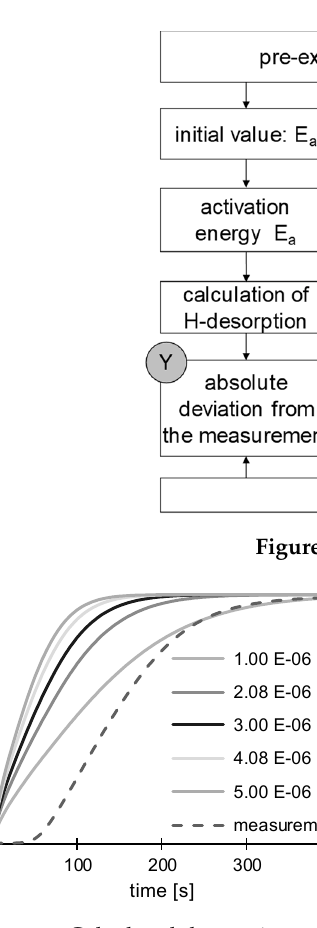
Figure 20. Calculated desorption curves at the beginning ( left ) and after completion of the iteration ( right ) by means of an isothermal 200 °C—measurement.